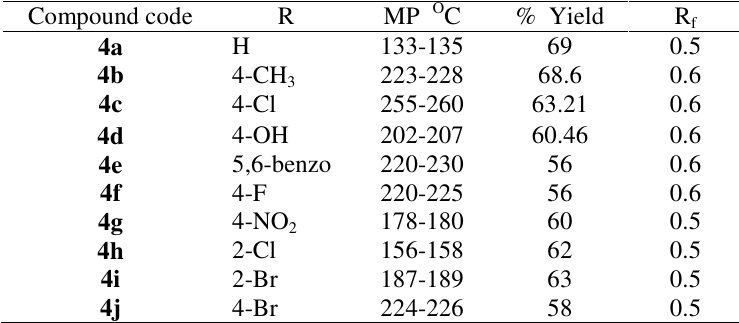
Table 1. Physical data of the compounds